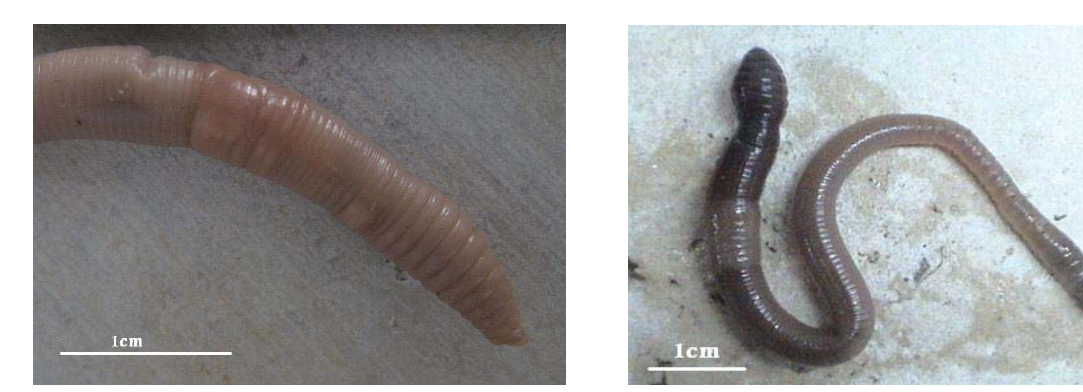
F IGURE 2. Aporrectodea caliginosa caliginosa. F IGURE 3. Aporrectodea caliginosa